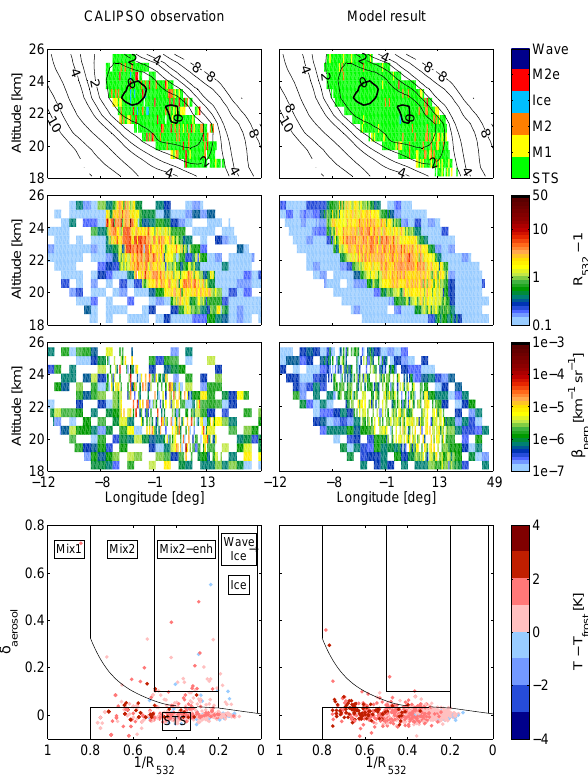
Fig. 9. 24 January 2010: CALIPSO orbit track 2010-01-24T03-01- 02Z. CALIOP measurements are shown in the left column, model results in the right column. Contour lines and the color-coded data presented in the lowermost row display ERA-Interim temperatures relative to T frost